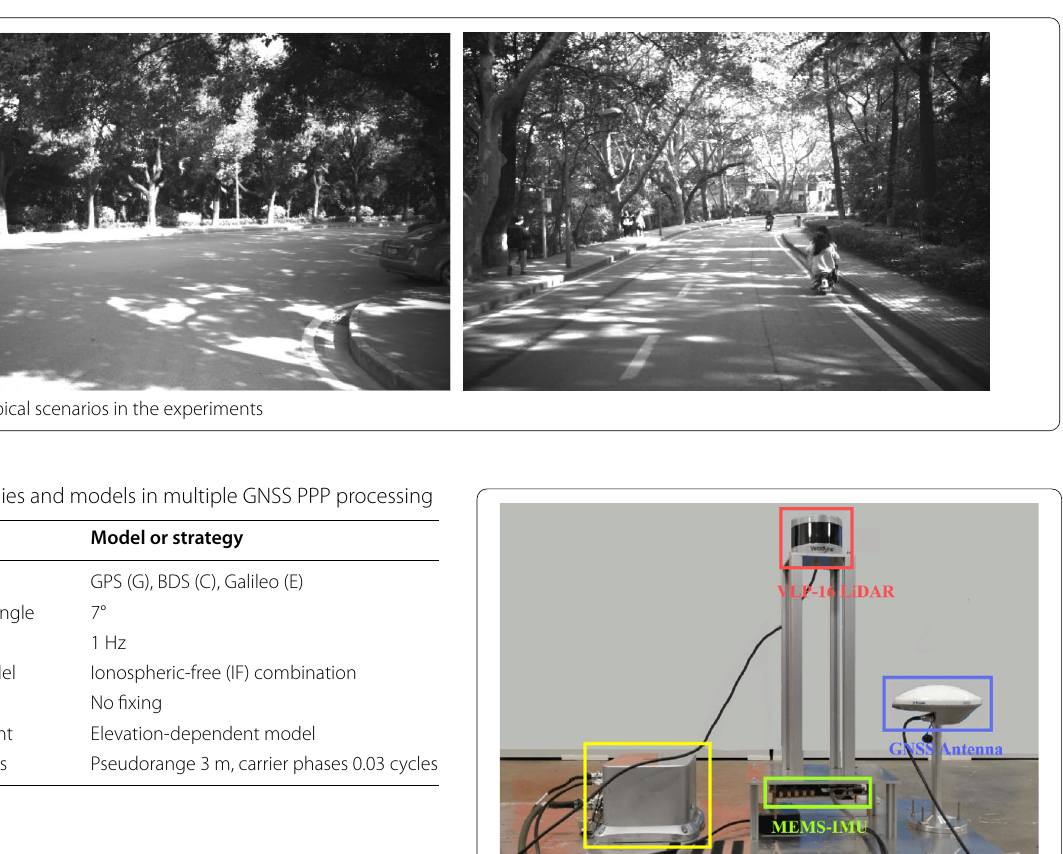
Table 2 Strategies and models in LiDAR processing